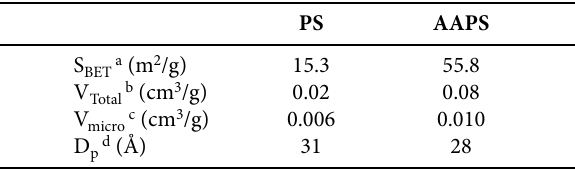
Table 2. The surface area and pore characteristics of natural (PS) and acid activated pistachio shell